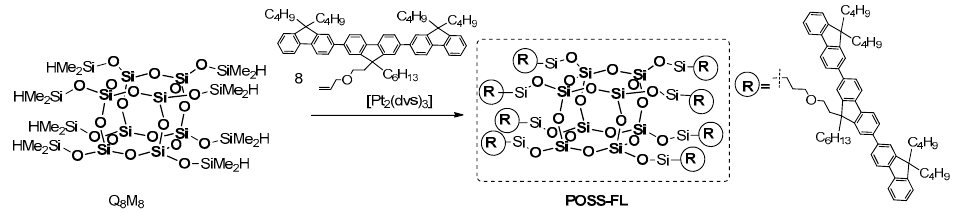
Figure 26. Synthesis of octakis(terfluorene)silsesquioxane via hydrosilylation.